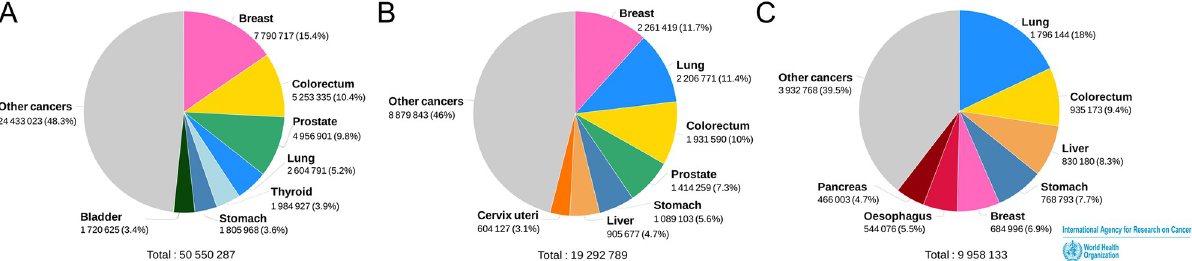
Fig 1. The worldwide estimated number of cancer in 2020. (A) Estimated number of prevalent cases (5-year) in 2020, worldwide, both sexes, all ages. (B) Estimated number of new cases in 2020, worldwide, both sexes, all ages. (C) Estimated number of deaths in 2020, worldwide, both sexes, all ages. (Datasource: Globocan2020 Graph production: Global Cancer